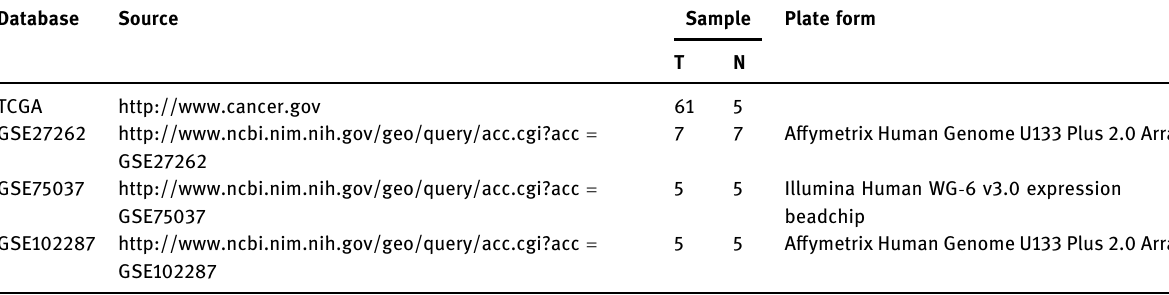
Table 1: Sample enrolled in the study from TCGA and GEO databases Database